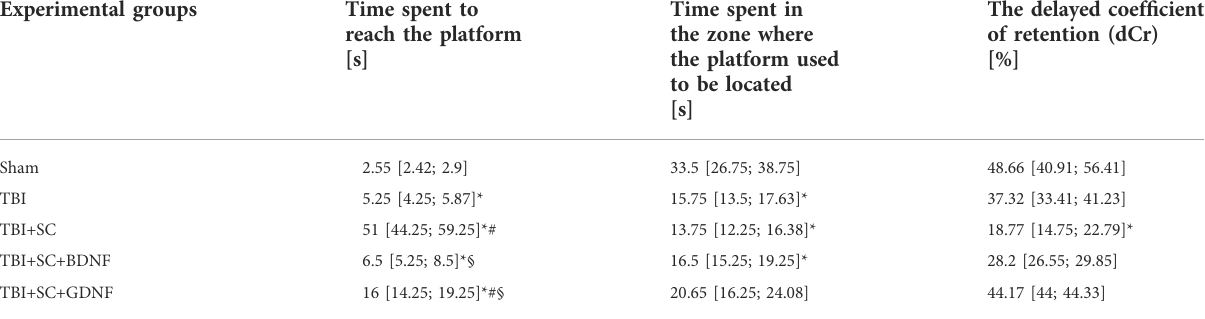
TABLE 5 Main parameters of long-term memory retention test of mice in the Morris water maze. Experimental groups